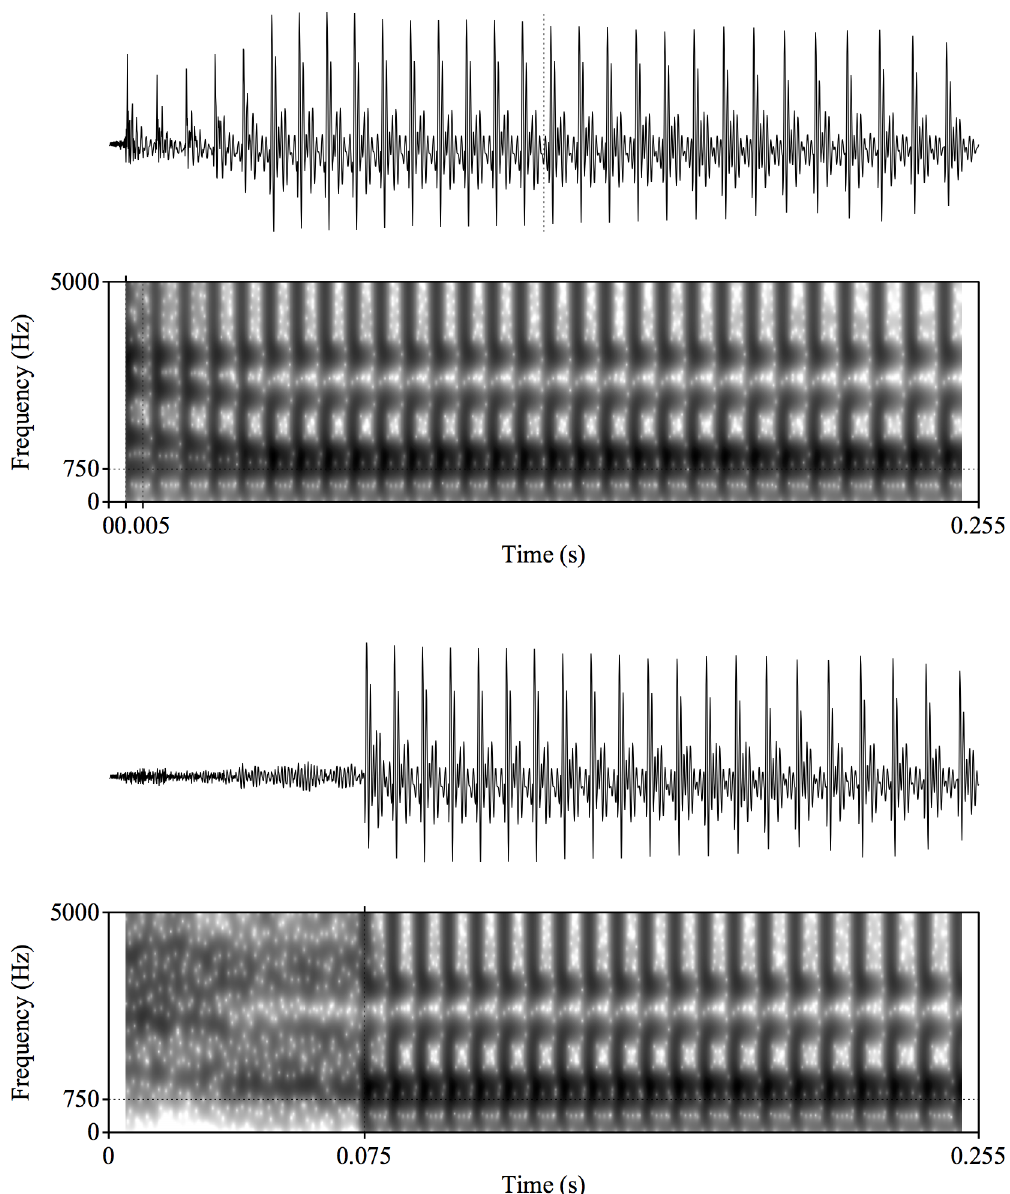
Fig 2. Spectrograms of synthetic speech syllables with high F1 frequency, "da" (upper box) and "ta" (lower box). The F1 frequencyfor both syllablesat the onset of voicingis 750 Hz. Both stimuli are 255 ms in duration.